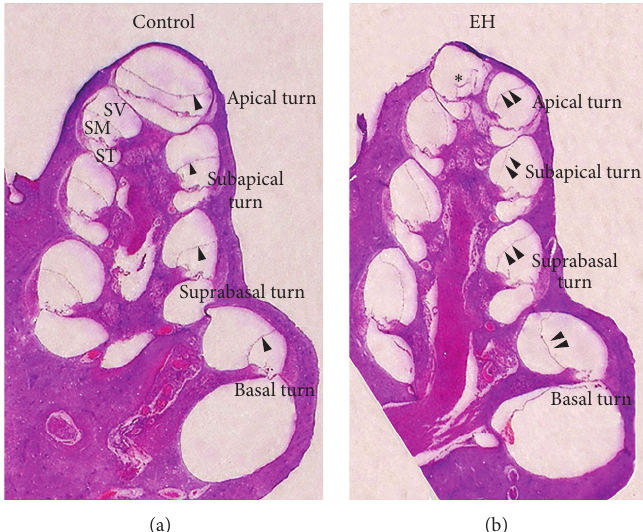
Figure 2: Mid-modiolar hematoxylin and eosin-stained section of the cochlea in the right ears of the control group (a) and the 8-week endolymphatic hydrops (EH) group (b). SV: scala vestibuli; SM: scala media; ST: scala tympani; arrowhead: Reissner’s membrane in the control group; double arrowheads: distention of Reissner’s membrane in the 8-week EH group; ∗ : rupture of Reissner’s membrane due to artifact in the apical